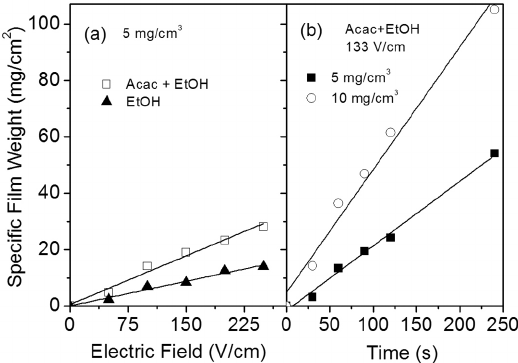
Figure 2. Specific deposited weight (deposition yield - mg/cm 2 ) of BTZ nanoparticles on platinum substrate varying with: (a) As a function of the electric field applied between the platinum substrates for EtOH and Acac+EtOH suspension (deposition time of 120s and concentration of 5 mg/cm 3 ). (b) Deposition time from two concentrations of EPD suspension (5-10 mg/cm 3 ) using the EtOH+Acac, electric field of 133V/cm and ball milling time of 120s.